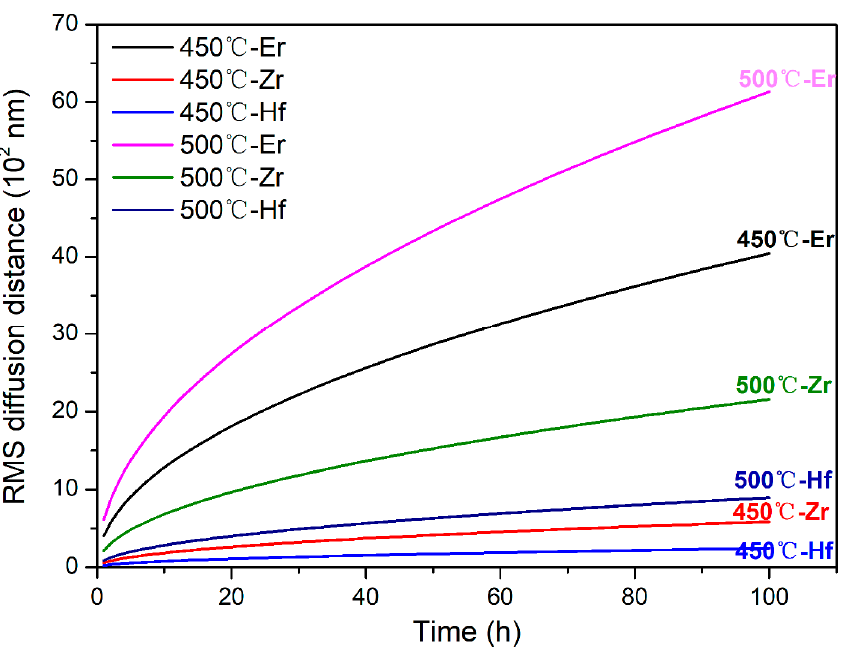
Figure 5. The RMS diffusion distance of Er, Zr, and Hf solute atoms in Al matrix at 450 °C and 500 °C.